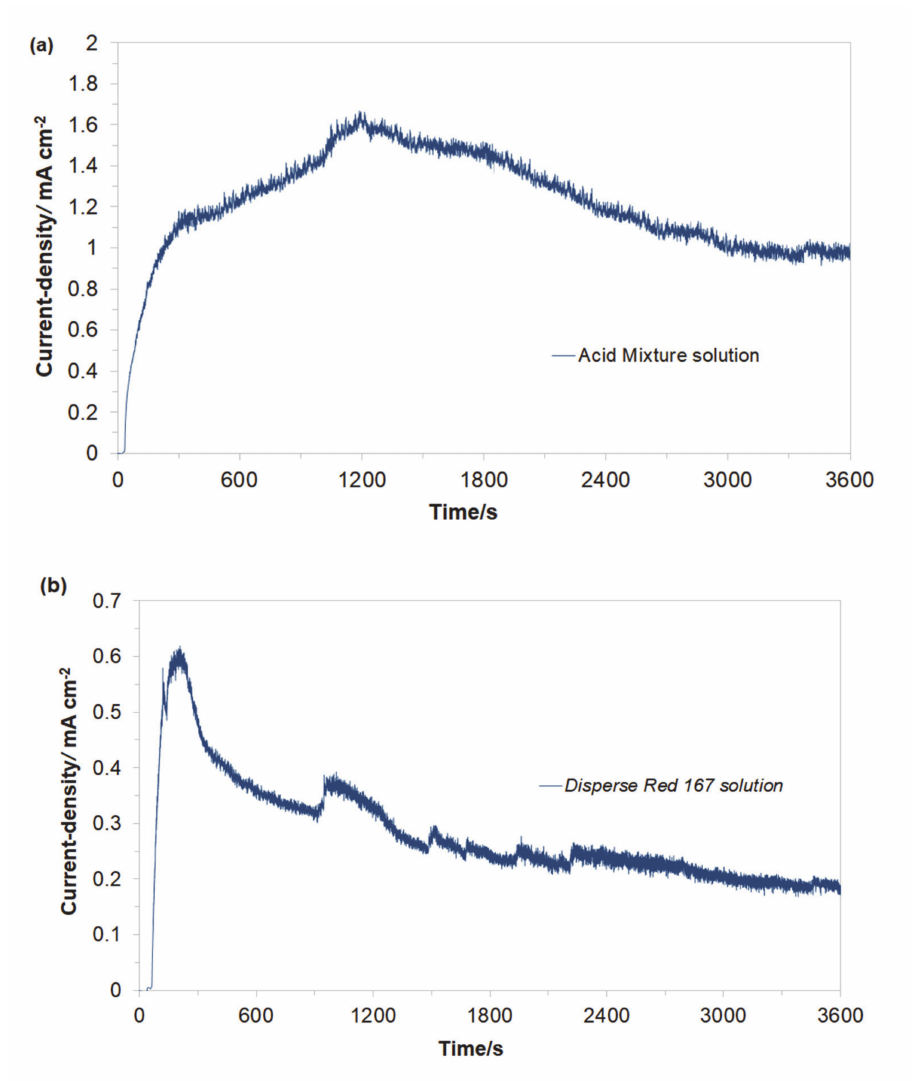
Figure 3. Recorded galvanic couple current-densities for macro-corrosion Cu / Al alloy galvanic cell in function of exposure time, derived for freshly-prepared, aerated Na 2 SO 4 -based solutions, containing ( a ) Acid Mixture and ( b ) Disperse Red 167 dyes, both at the concentration of 50 mg dm − 3